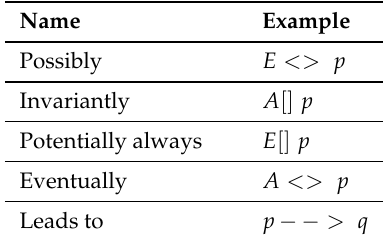
Table 1. Properties in Uppaal.